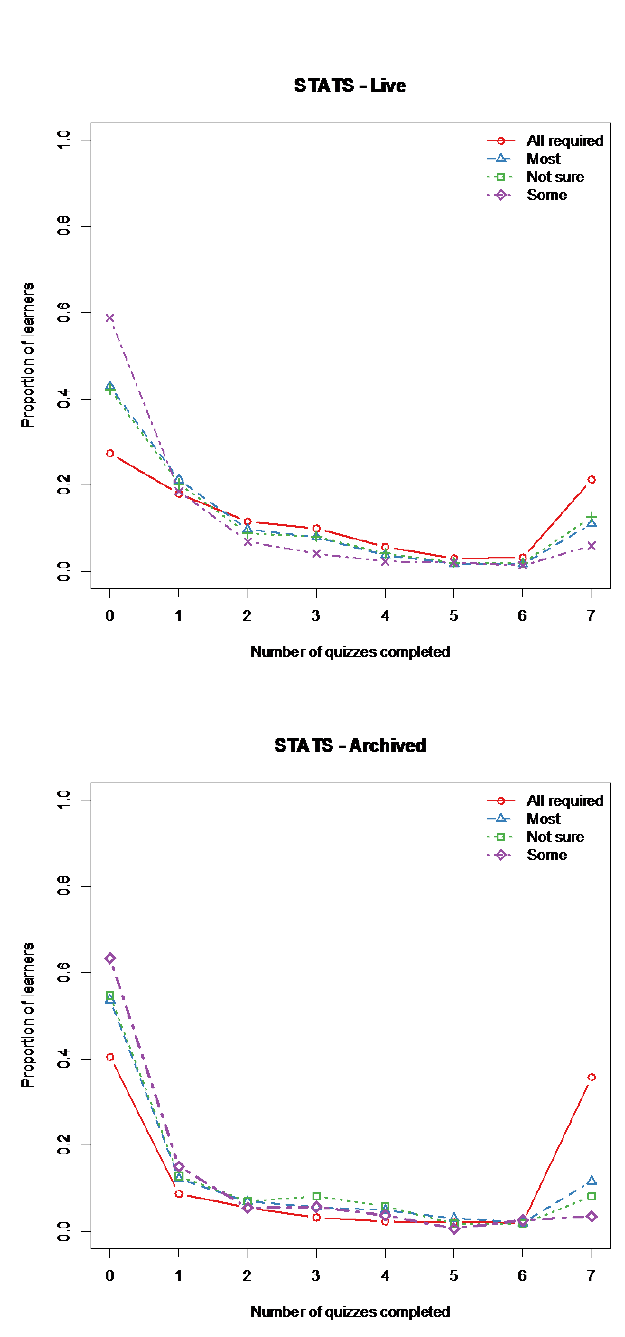
Figure 7. Number of quizzes completed by STATS live- and archived-learners, by intent.